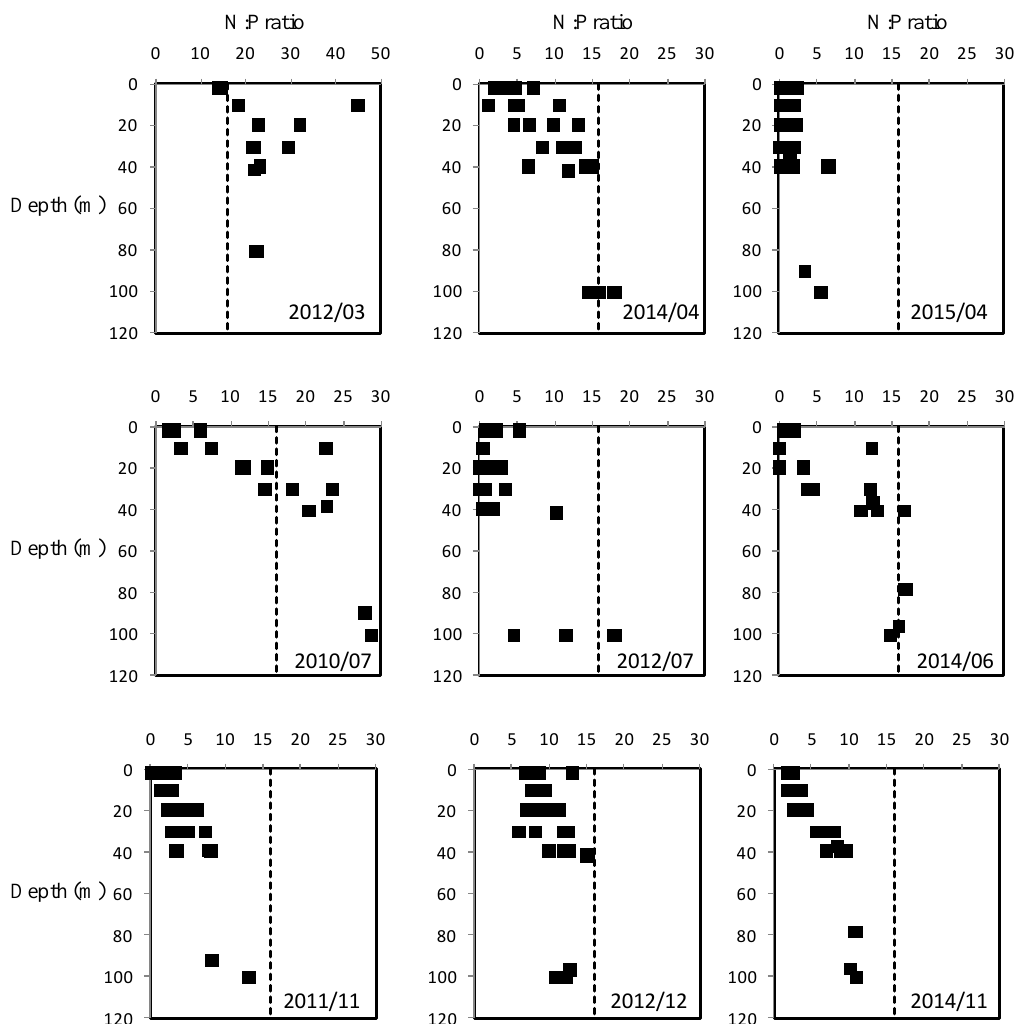
Figure 5. Variation along depth of the molar ratio nitrate+nitrite to phosphate (N:P) obtained during surveys in the Bay of Algeciras. For each depth, the N:P ratio obtained in the four sampling stations are shown. Vertical dashed lines indicate the Redfield ratio (16:1). Note the different y -axis scale for 2012/03. Data were grouped according to three seasonal periods: spring (top), summer (middle), and autumn (bottom).